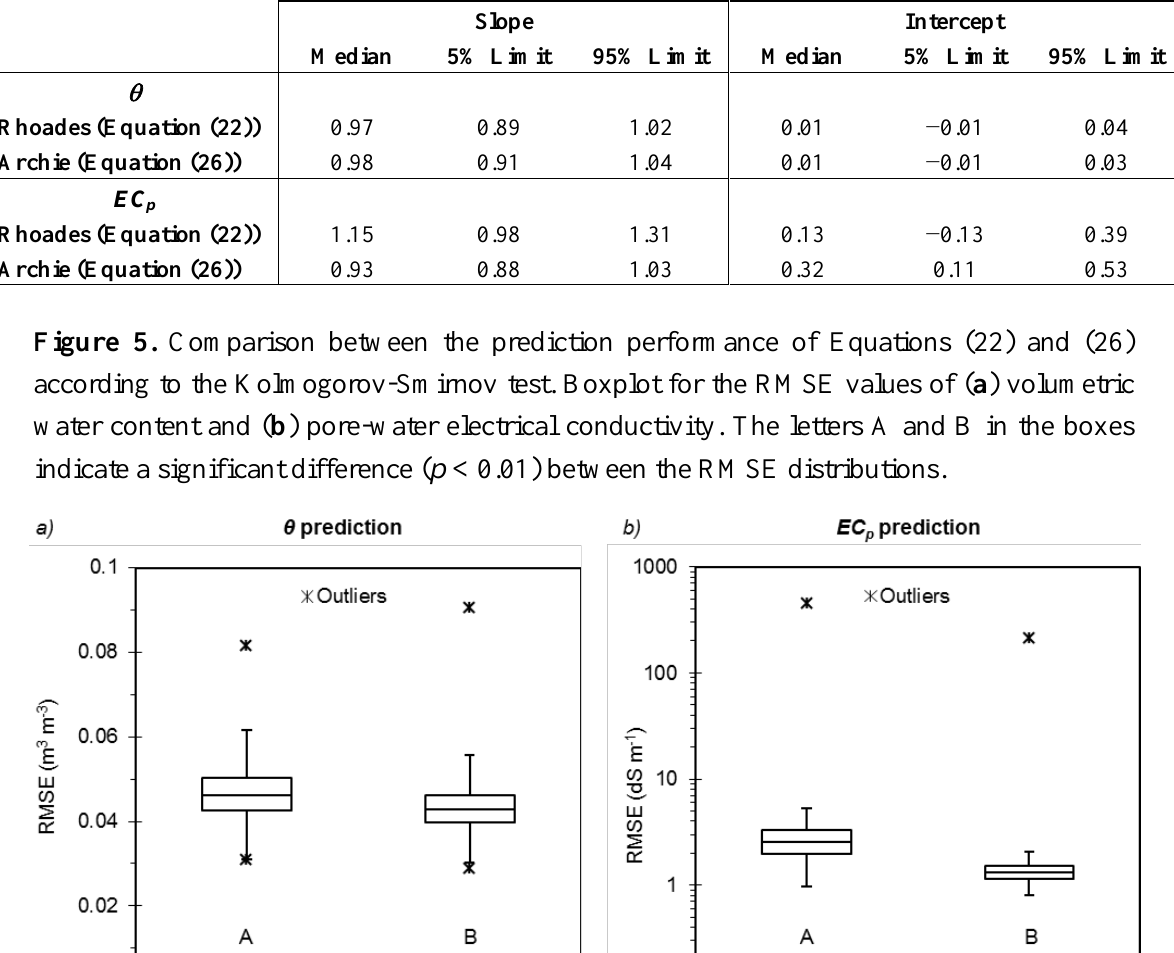
Table 4. Statistical analysis of the bootstrap validation outcome: median, 5th, and 95th percentile of slope and intercept distributions of the observed-predicted relationships for volumetric water content and pore-water electrical conductivity using Equations (22) and (26).